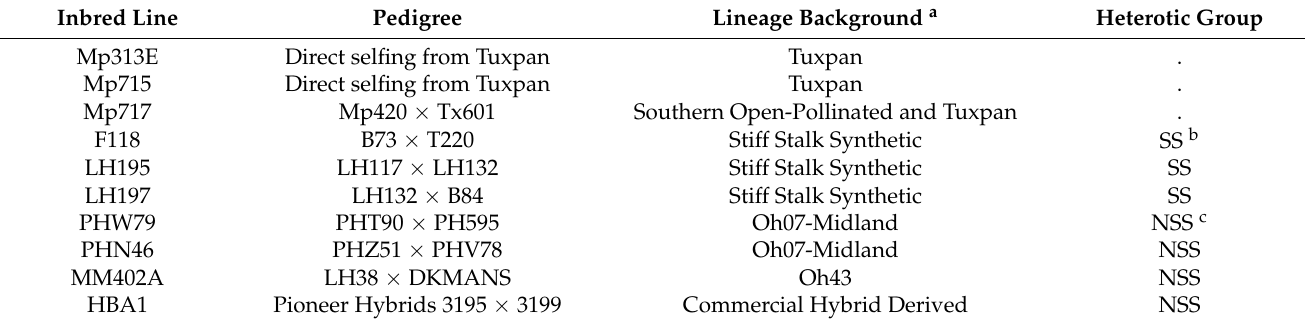
Table 2. Pedigrees, lineage background, and heterotic group for ten maize inbreds constituting a diallel. Inbred